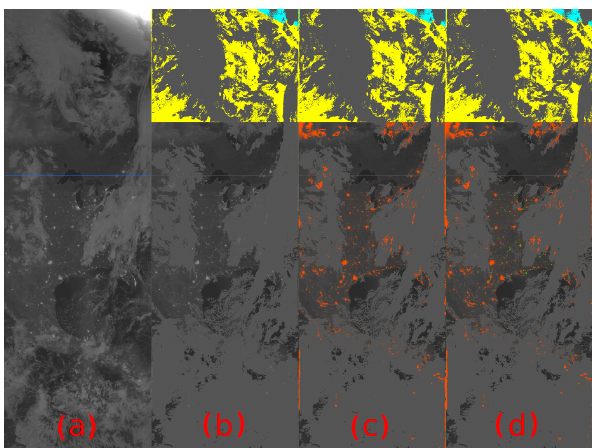
Figure 2. (a) VIIRS DNB contrast-enhanced imagery centered over North America from the VIIRS DNB for 1 October 2015. Panel (b) is the same as (a) but with cloud screening and quality assur- ance steps applied for cloudy (gray), saturated pixels (yellow) and solar zenith angles <102 ◦ (cyan). Panel (c) is similar to (b) but with artificial light sources identified through a granule-level detection (orange). Panel (d) is similar to (c) but shows artificial light sources cross-checked with a known city database and through a regional- level detection (green).